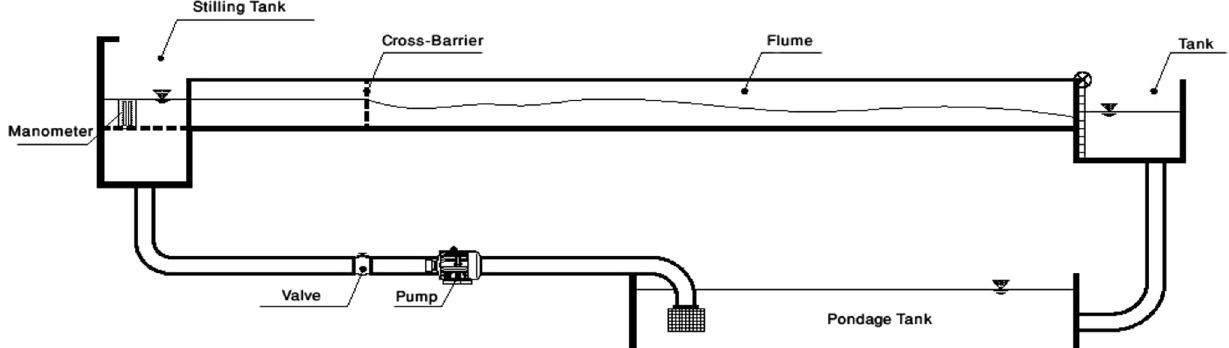
Fig. 4 Experimental setup